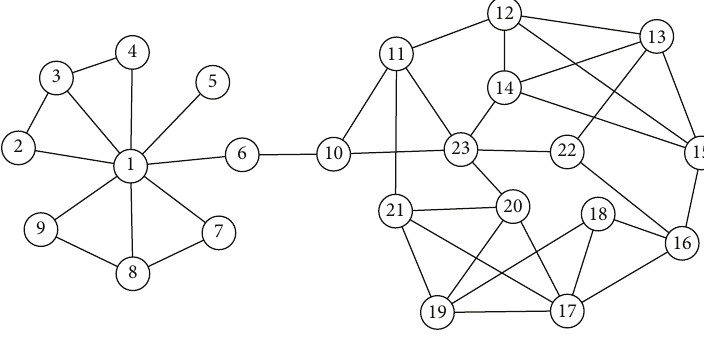
Figure 7: The network referred from literature [11]. Table 5: The ranking results and precisions of four algorithms and SIR model for the ChenNet network. Algorithm